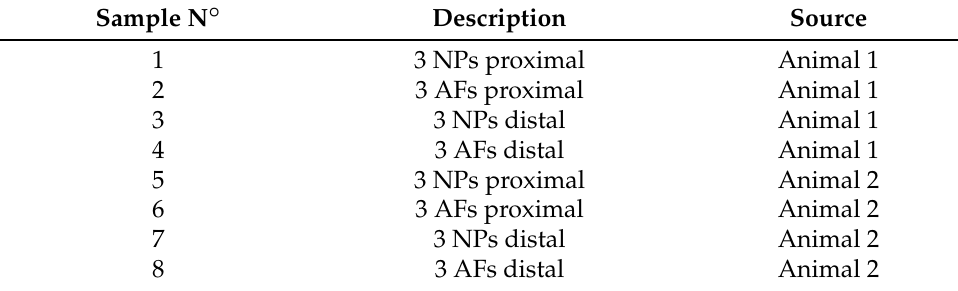
Table 1. Samples scRNAseq. List of samples used for single-cell sequencing.